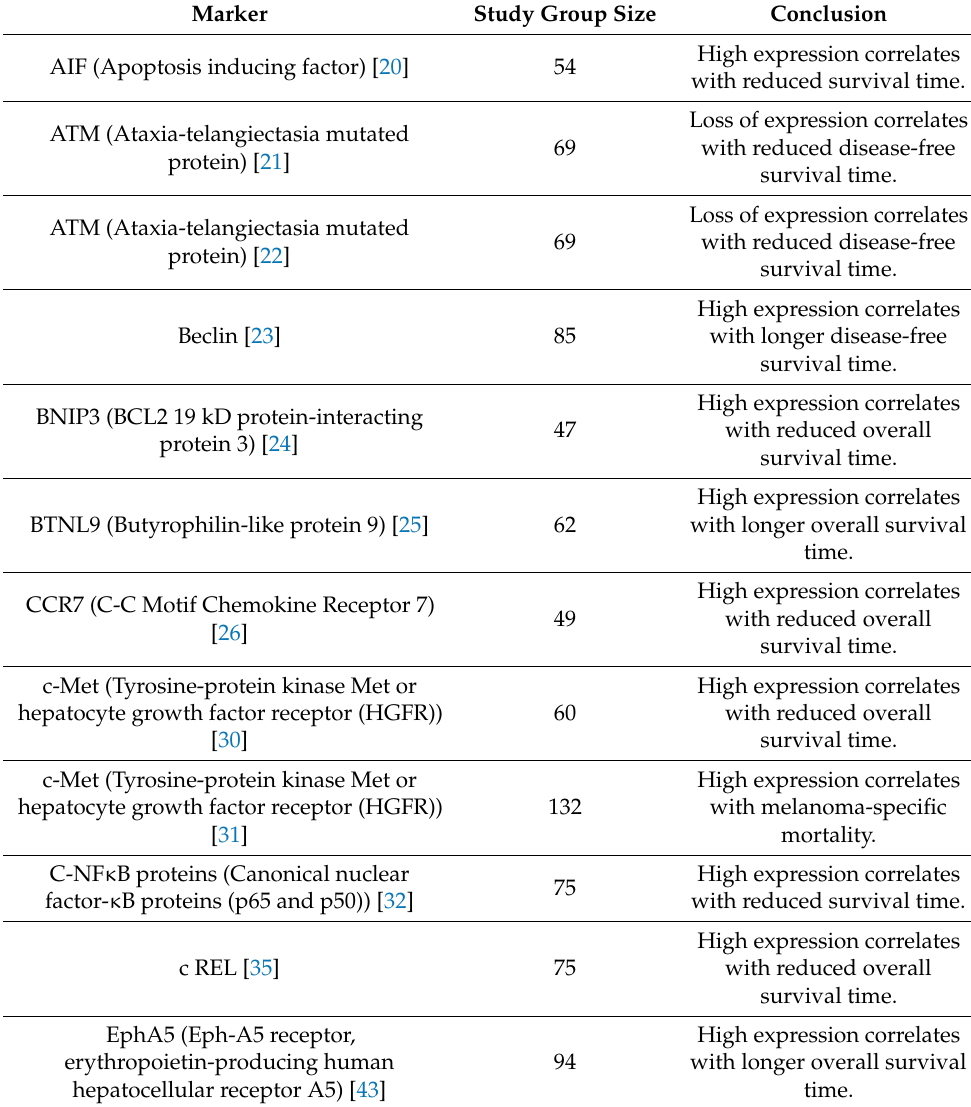
Table 12. Summary of markers whose expression is related to survival times. Marker Study Group Size